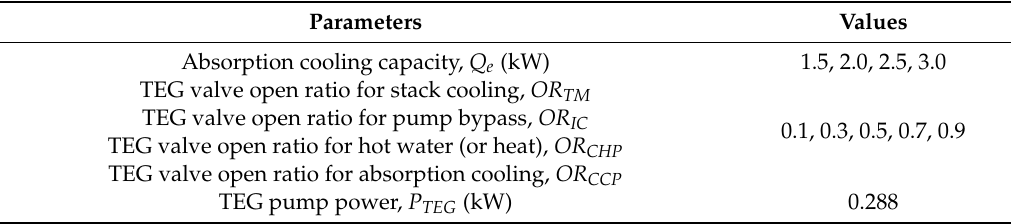
Table 5. Open ratio of thermal management fluid distribution valves and operating conditions of the heating and cooling